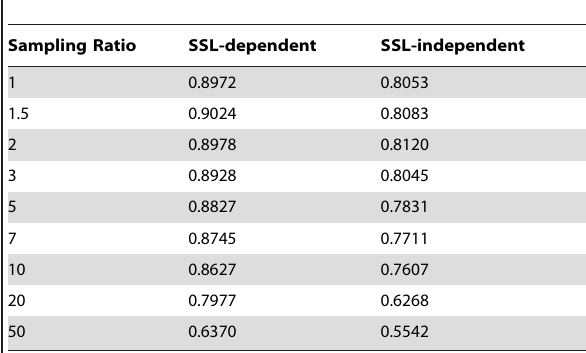
Table 1. Dependence of the AUC scores of the ensemble classifiers trained using SSL-dependent and SSL-independent features on the sampling ratio used to generated the training set for Wong et al’s SSL data set